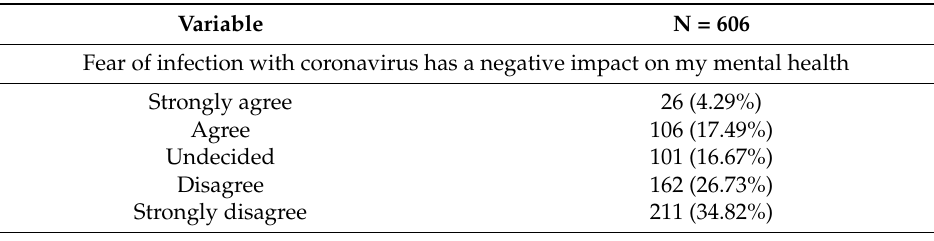
Table 2. Attitudes and habits related to the